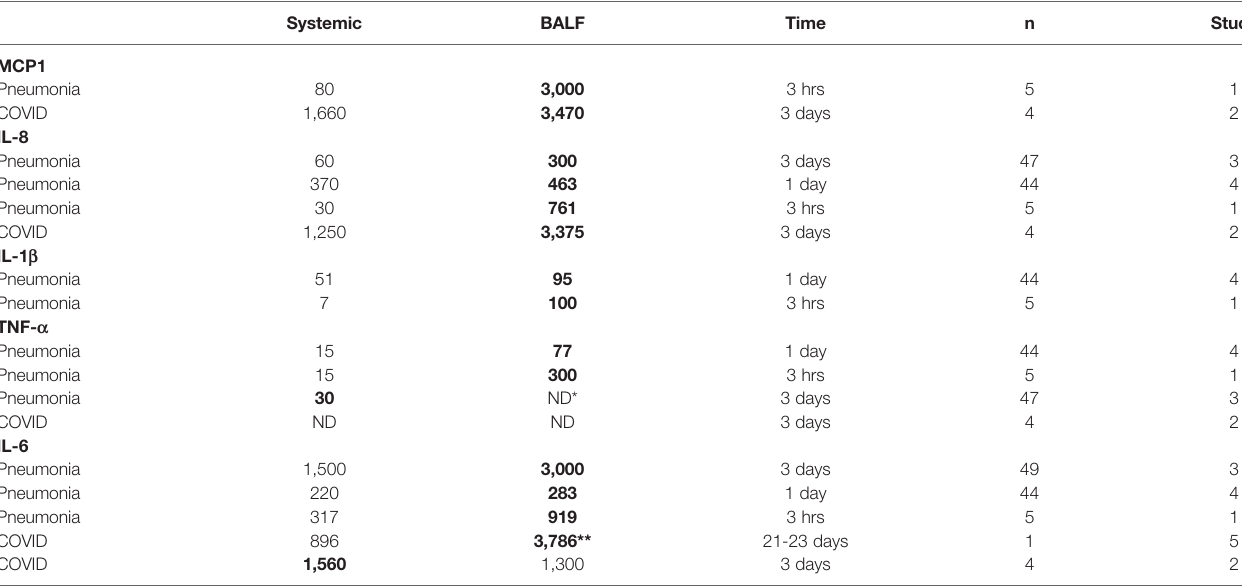
TABLE 1 | Systemic and bronchoalveolar lavage fl uid (BALF) cytokines in ARDS of pulmonary origin.